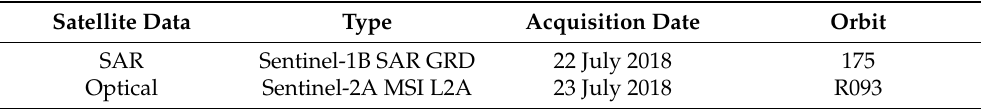
Table 2. Satellite imagery type, acquisition date, and orbit used for the TSB estimation.